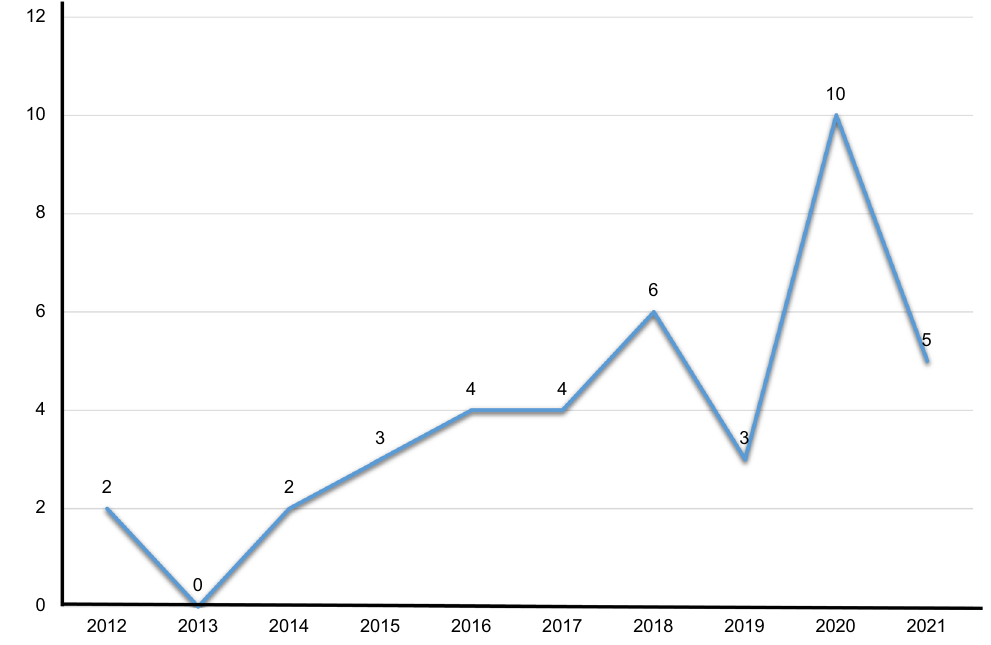
Fig. 3 Number of publications on R‑STEM education from 2012 to 2021